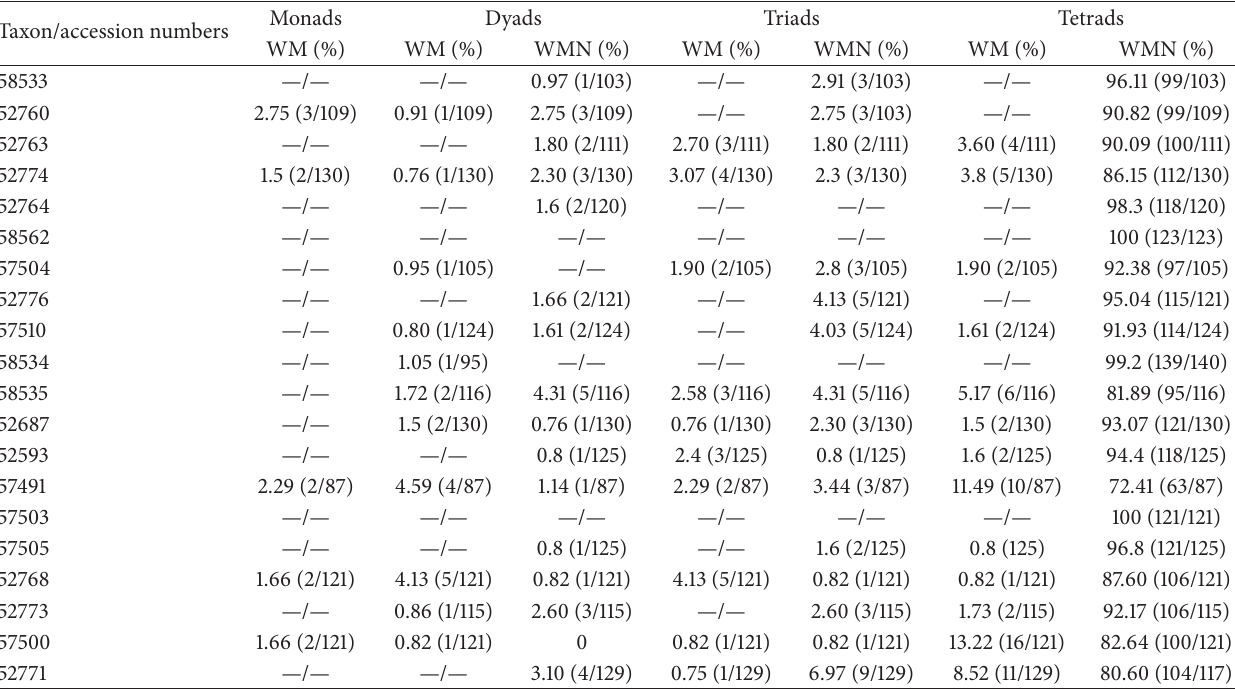
Table 4: Data on abnormal microsporogenesis on different accession of tribe Cichorieae from Western Himalayas. Taxon/accession